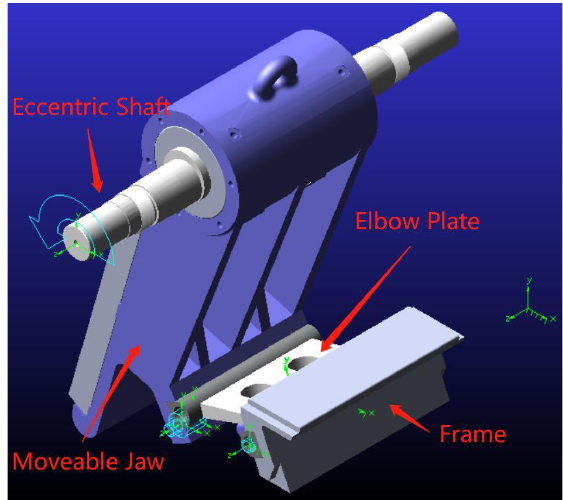
Figure 4. Adams virtual simulation interface.